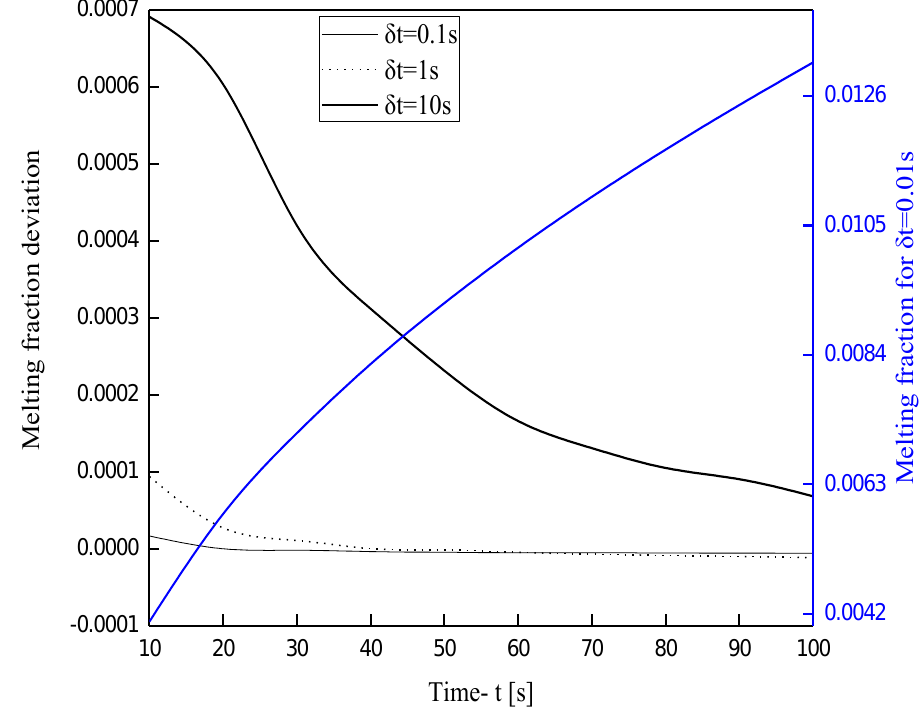
Figure 5. Melting fraction variation for various time steps.